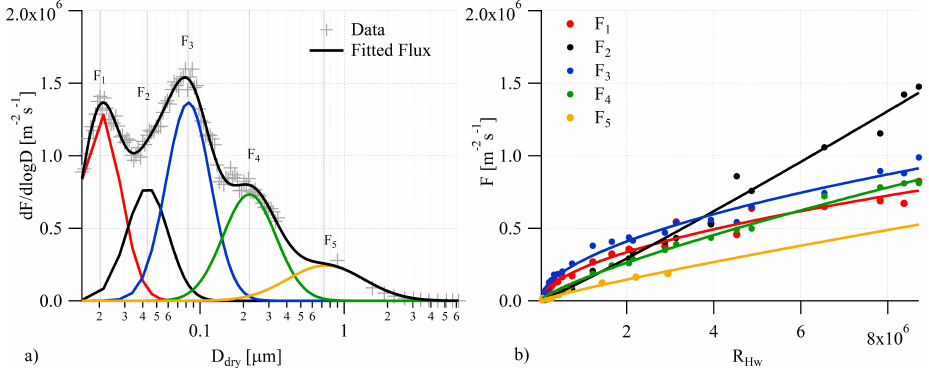
=3.1 × 10 6 ( U 10 ∼ 18ms − 1 ): markers represent the mea- w